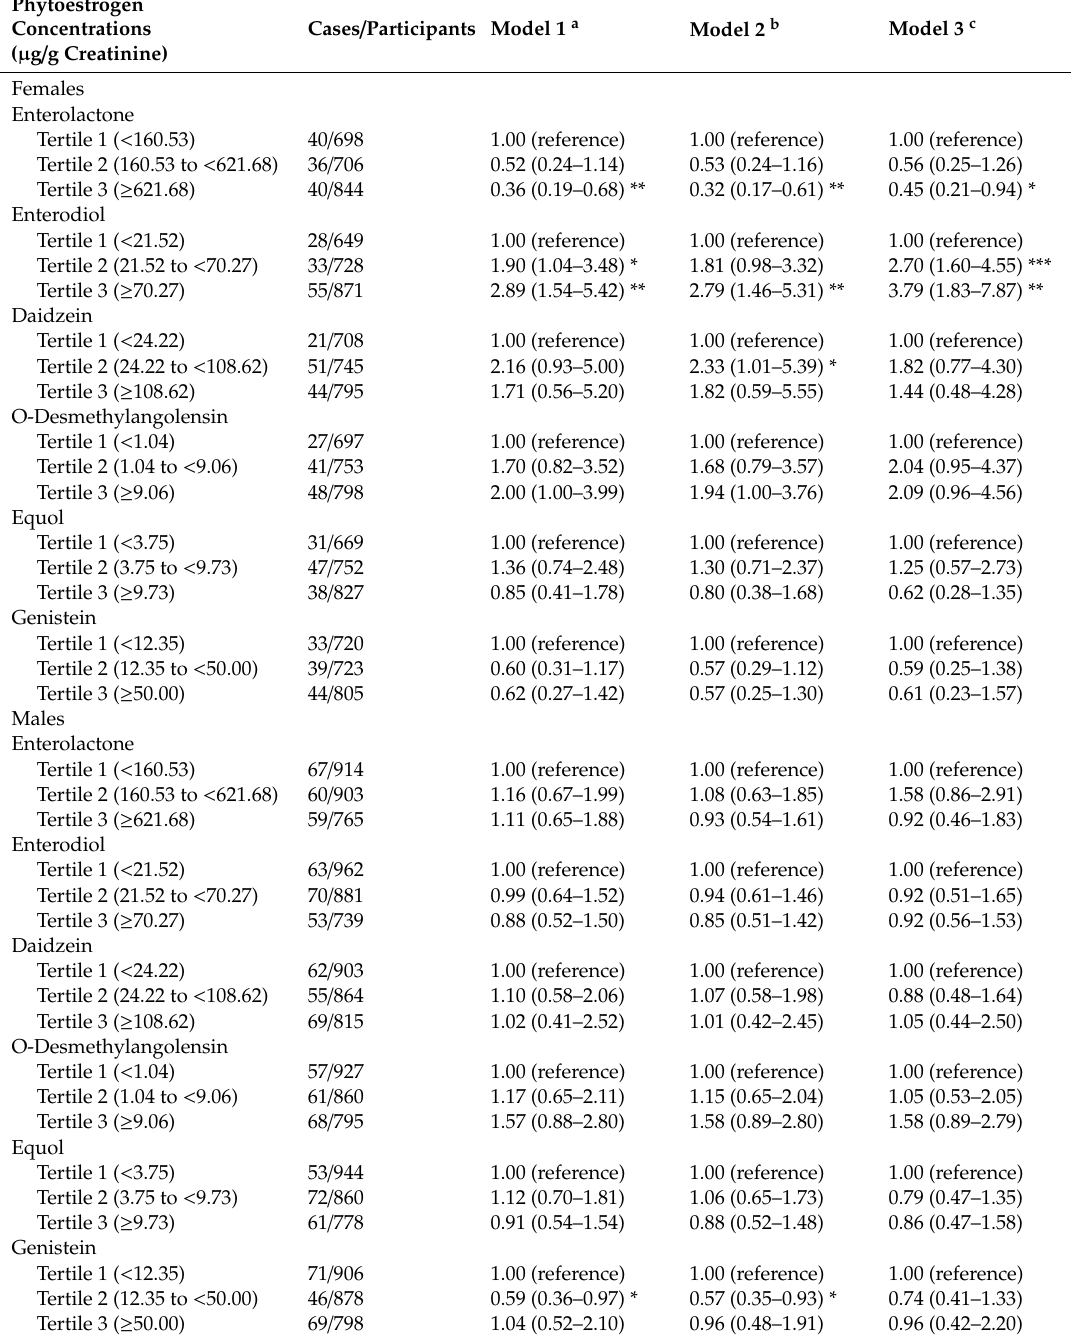
Table 4. Weighted odds ratios (95% confidence intervals) for sleep disorders across tertiles of urinary phytoestrogen concentrations stratified by gender (National Health and Nutrition Examination